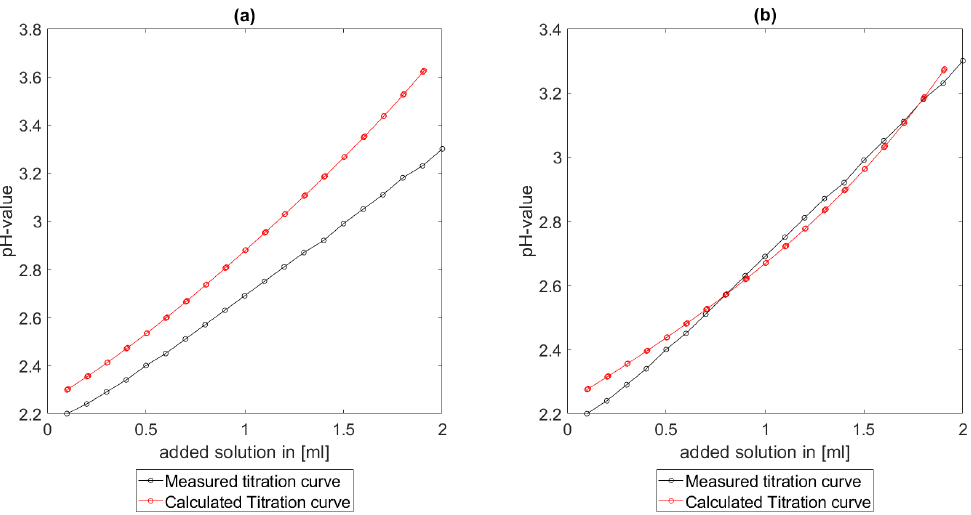
Figure 12. ( a ) Comparison of calculated titration curve, for the Cit-Ni electrolyte, with stability constants given in the literature, see Figure 7 and measured titration curve on a reduced addition interval. ( b ) Comparison of measured and optimized titration curves, for the Cit-Ni electrolyte on a reduced addition interval. The results of the optimization are found in Table 7.